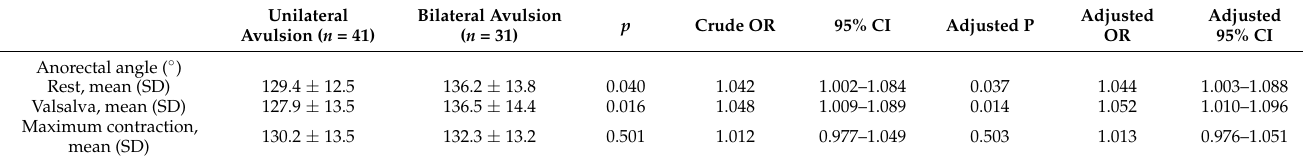
Table 4. The ARA in patients with unilateral LAM avulsion and in patients with bilateral LAM avulsion. ORs were adjusted for maternal age in